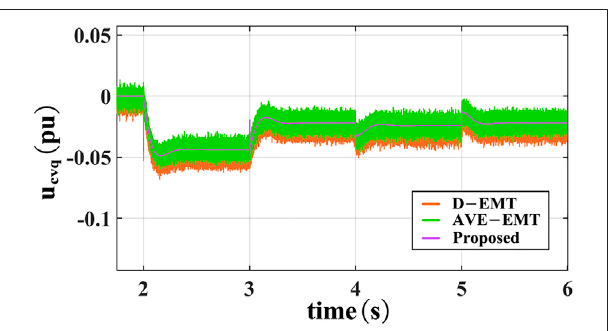
FIGURE 13 | Per-unit waveform of u cvq .